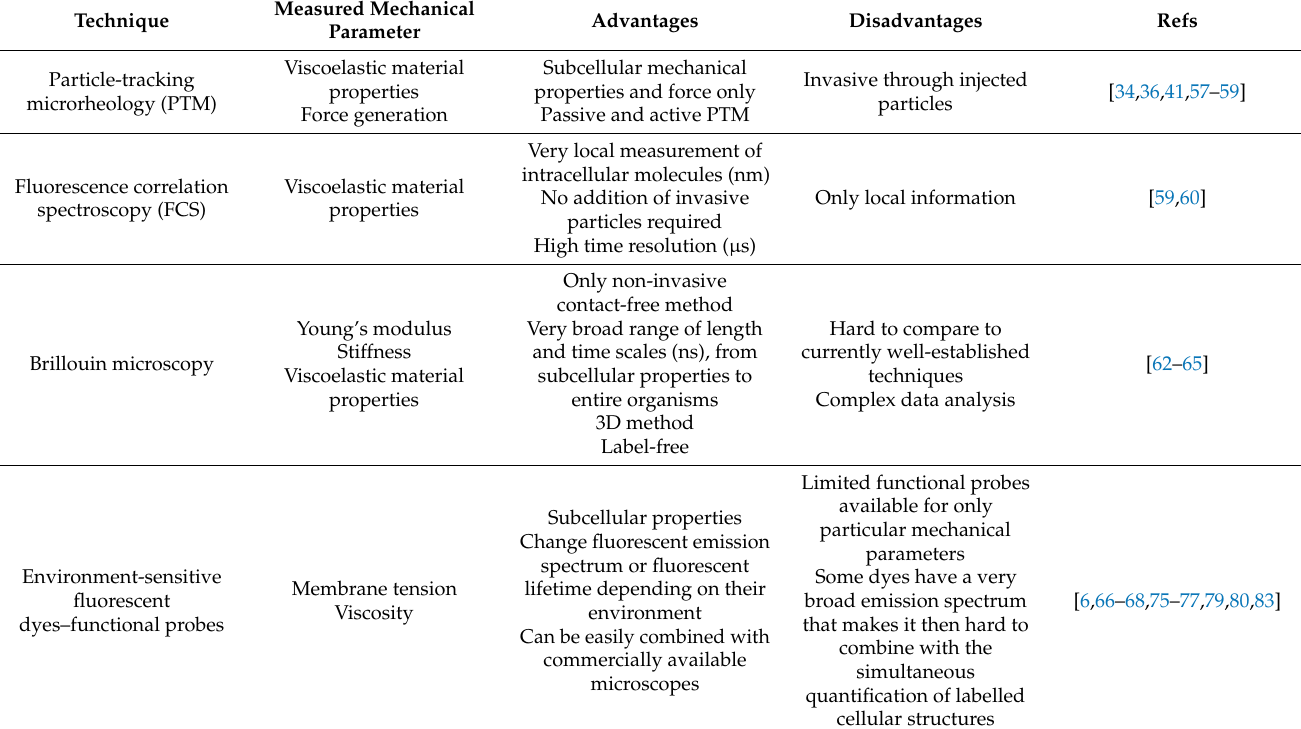
Table 2. Some of the most common methods to measure mechanical properties in biomechanics and mechanobiology that do not rely on a direct physical contact with cells linked to the measured mechanical